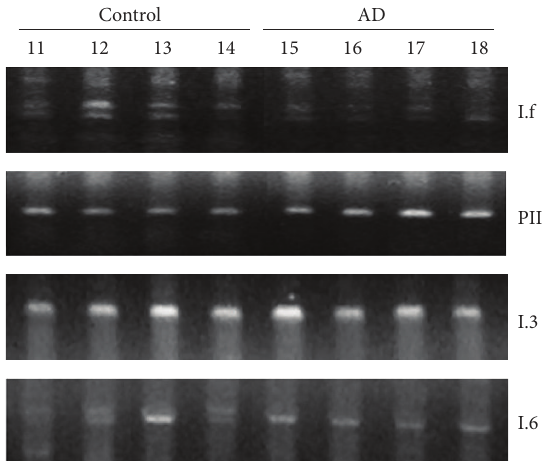
Figure 3: Various types of aromatase first exons were expressed in the hippocampi from patients without neurological diseases and patients with AD . RT-PCR using primer sets specific for different first exons of aromatase mRNA showed that several different promoters, namely, I.f, PII, I.3, and I.6, regulate aromatase expression in the hippocampus. The respective first exons were expressed in healthy hippocampi as well as in hippocampi from patients with AD. The numbers given for each sample refer to Table S1 (sample numbers